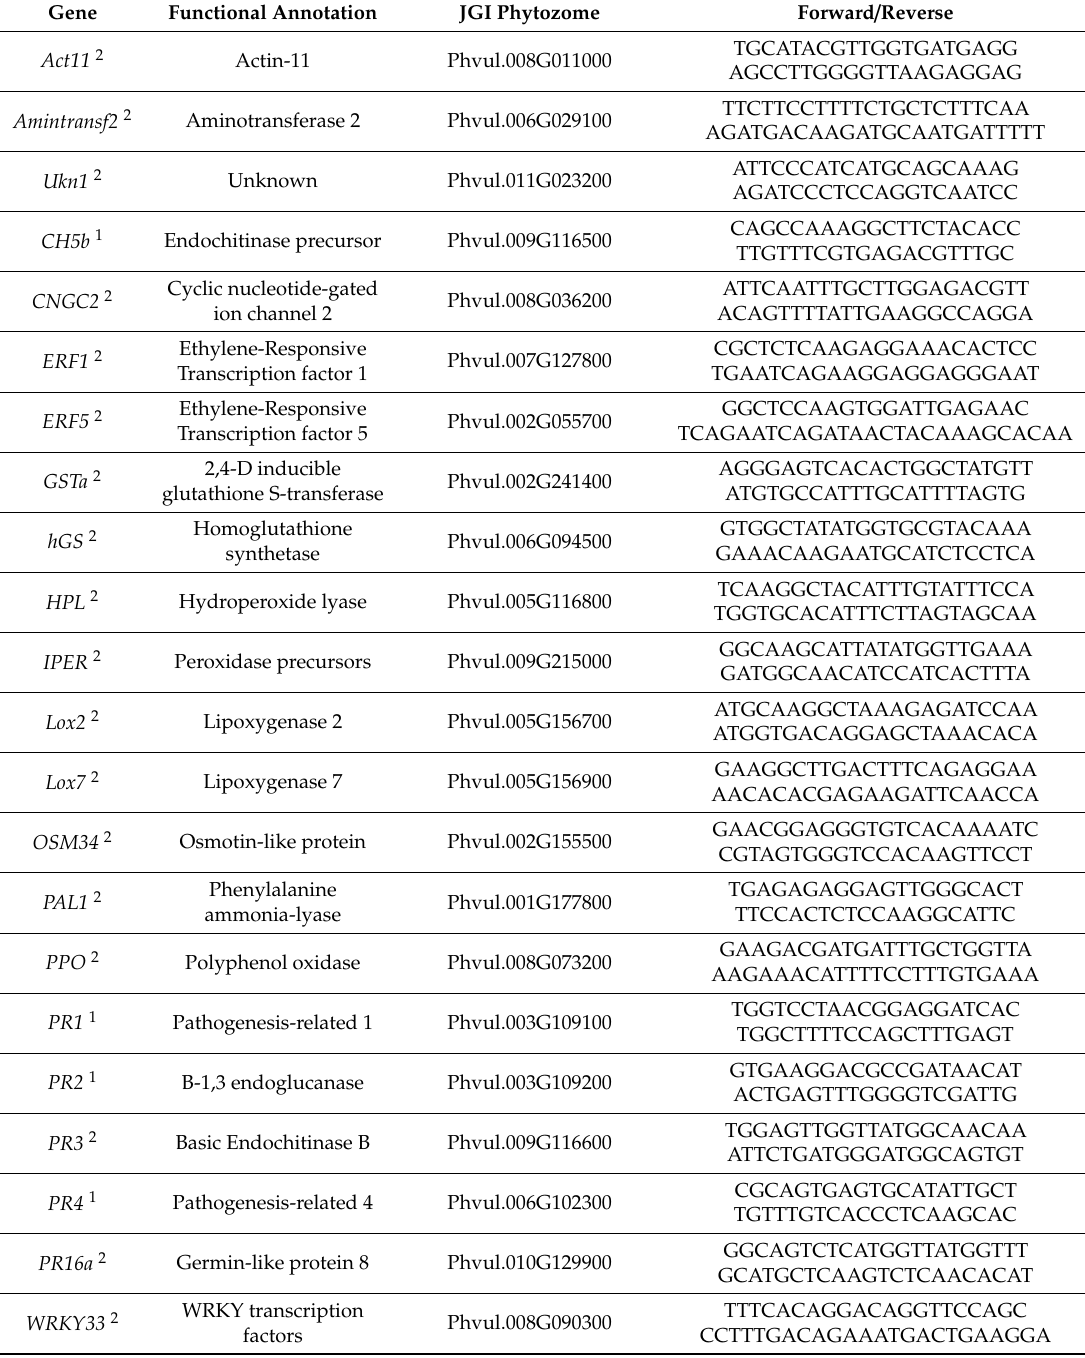
Table 2. Primer sequences used for RT-PCR analysis in common